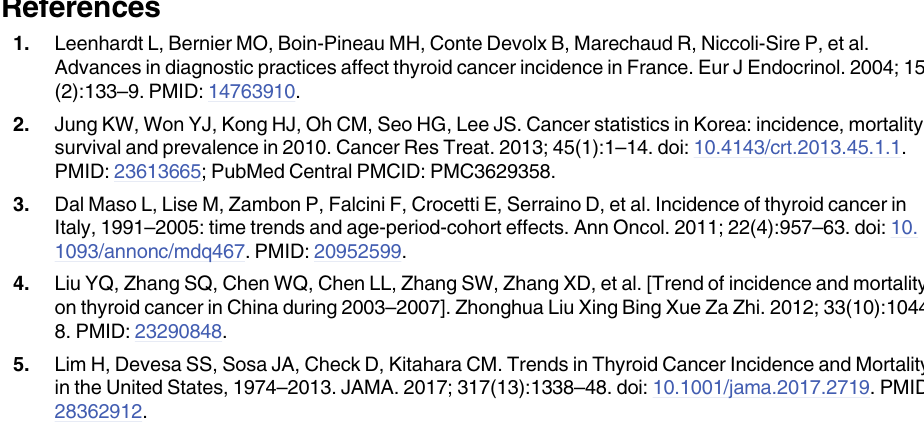
S1 Table. PRISMA checklist. S1 Fig. PRISMA flow